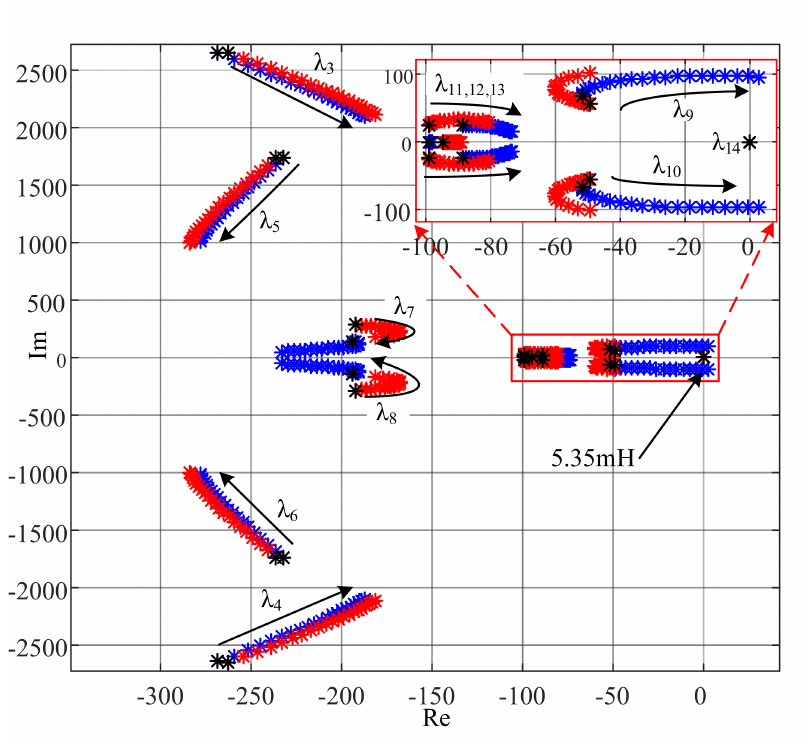
Figure 8. Sensitivity of system eigenvalues under variation of grid